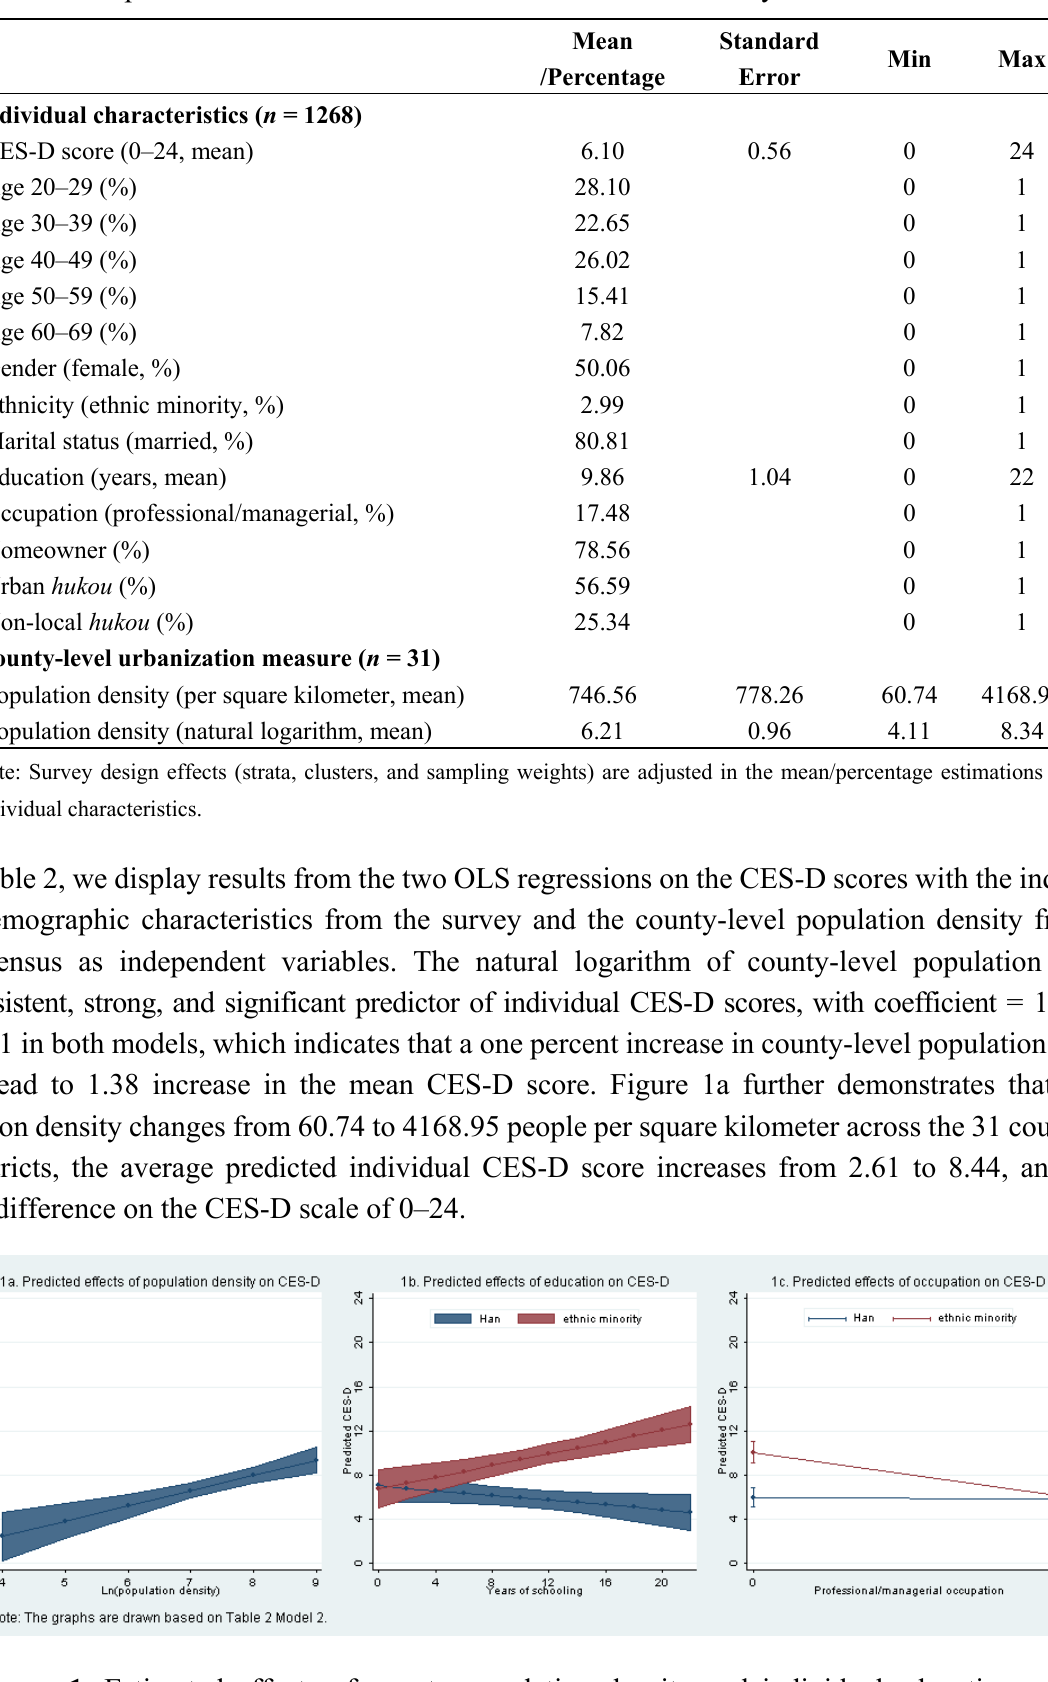
Figure 1. Estimated effects of county population density and individual education and occupation on CES-D